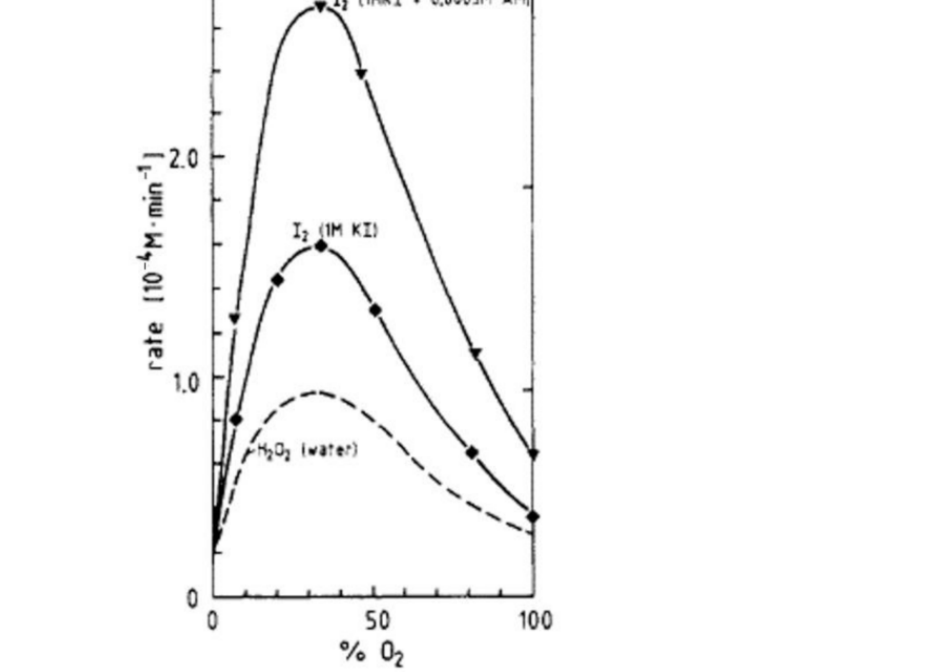
Figure 11. Experimental results on the rate of production of H 2 O 2 in pure water and that of I 2 in 1 M KI solution or 1 M KI + 0.0005 M ammonium molybdate solution under various mixtures of argon and oxygen dissolved in the solution irradiated with ultrasound of 300 kHz [122]. Copyright 1985, with permission from the American Chemical